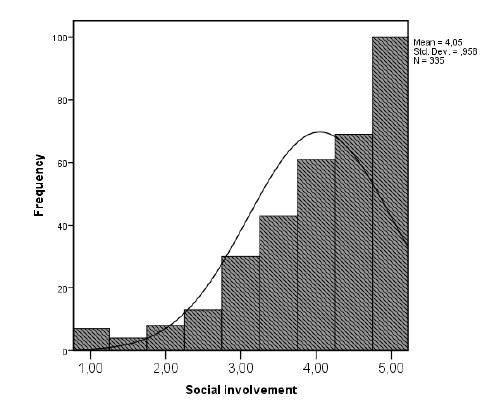
Fig. 3 – Distribution of a social involvement factor Source: own